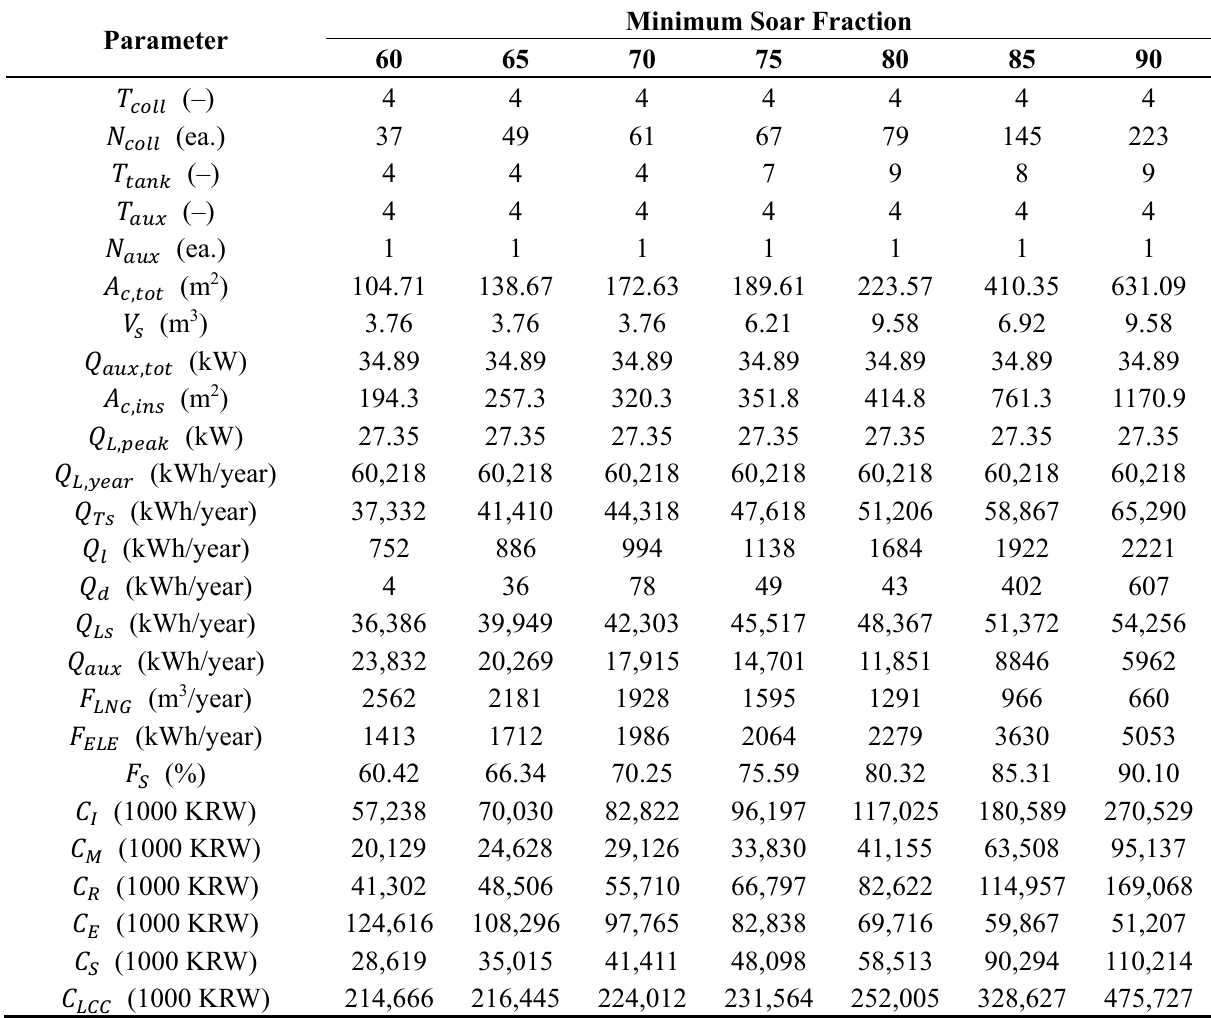
Table 8. Characteristics of the optimal SWH systems for the different minimum solar